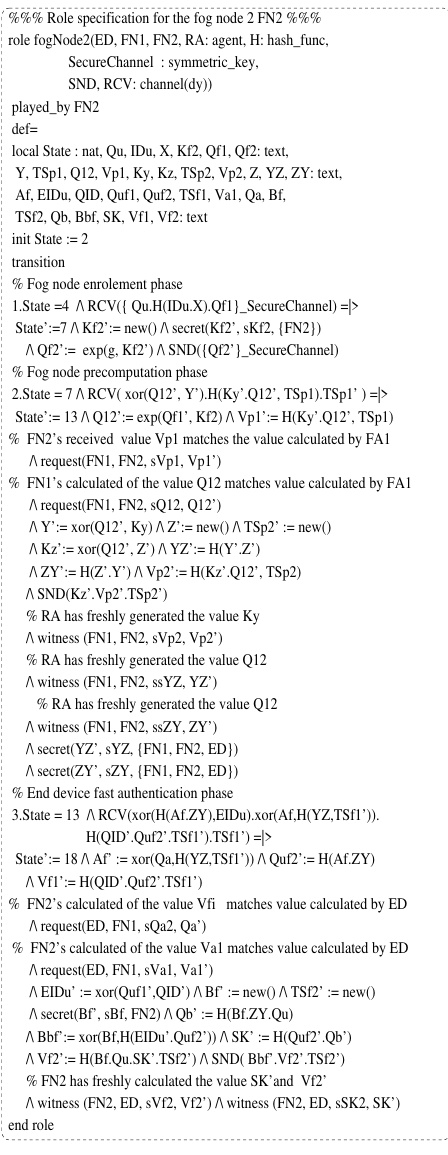
Figure 8. HLPSL role specification for fog node 2 ( FN 2 )